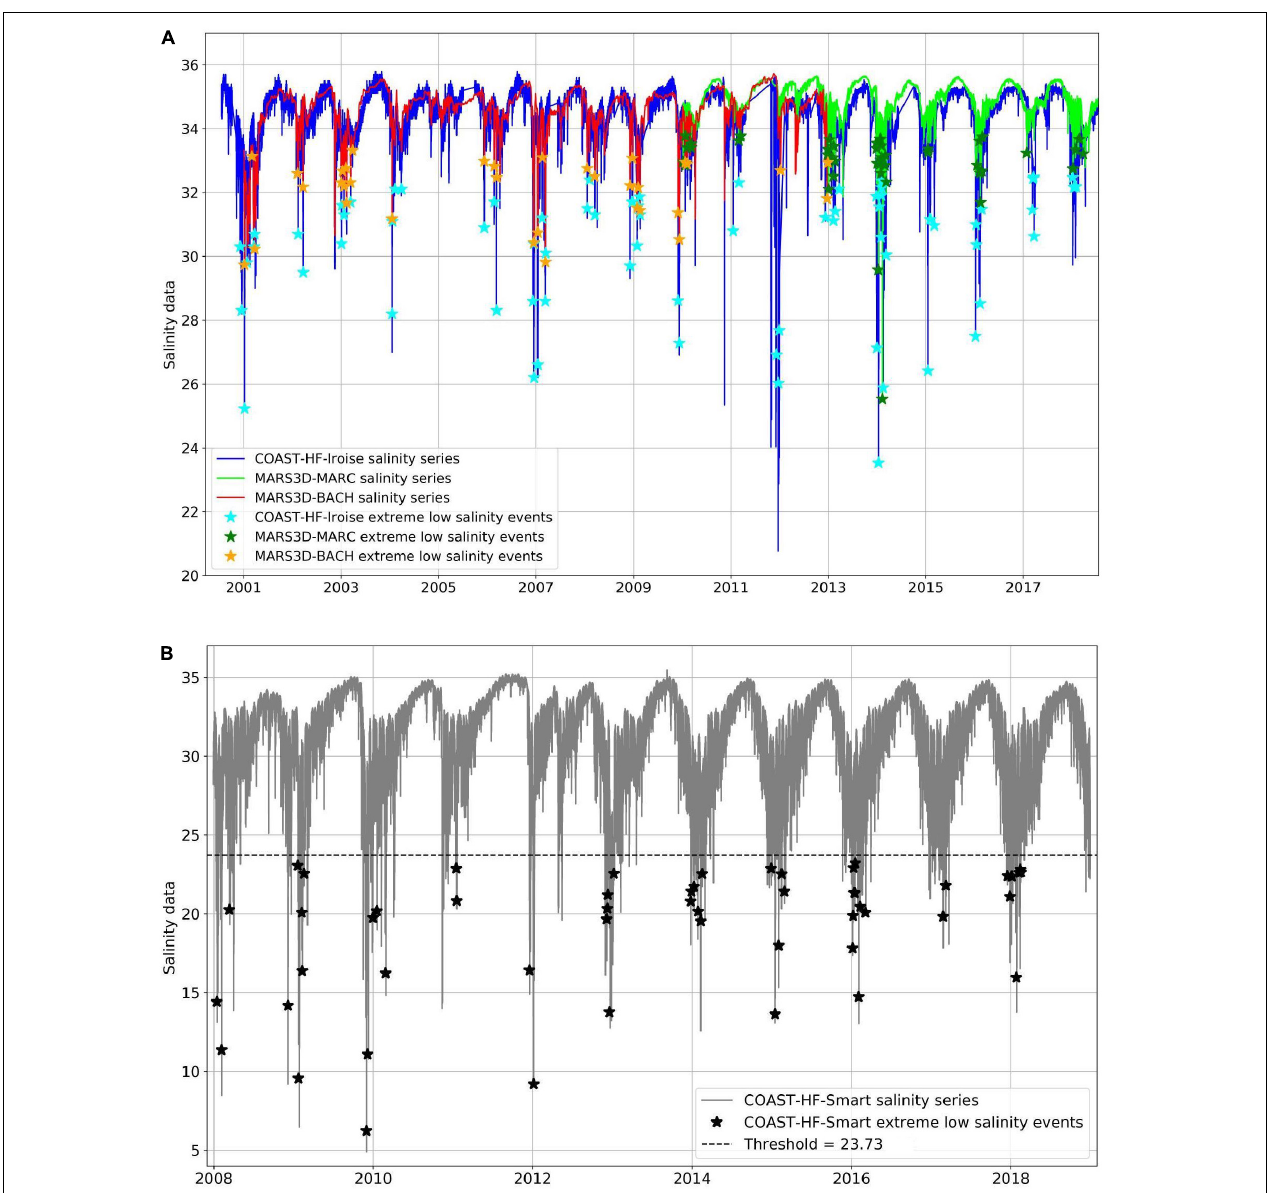
FIGURE 2 | Time series of salinity and detected extreme low salinity events indicated with stars for (A) the observed data at COAST-HF-Iroise buoy (in blue) and the modelled data of the MARS3D–BACH (2001–2013, in red) and the MARS3D–MARC (2010-mid-2018, in green) simulations and (B) the observed data at the COAST-HF-Smart buoy (in grey). The dashed line represents the threshold salinity value of 23.73 determined from the percentile